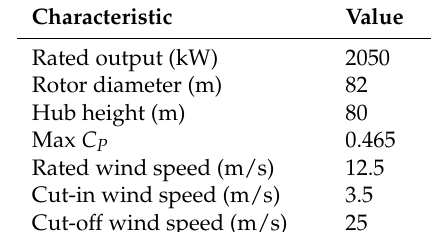
Table 1. Senvion MM82-2050 kW turbine characteristics.